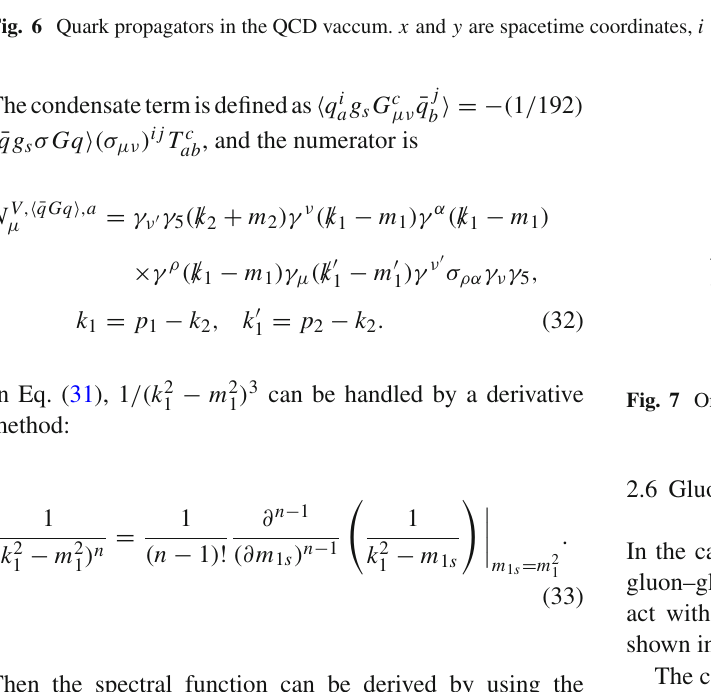
Fig. 5 Mixed quark–gluon condensate diagrams